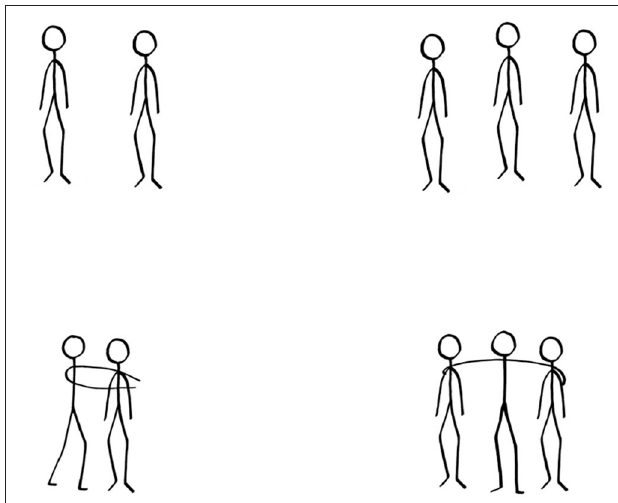
FIGURE 1 | A schematic representation of the prime images in the distancing (top panel) and proximity (bottom panel) prime conditions with 2 (leftward panel) and 3 (rightward panel) stick figures. Note that elements are not drawn to